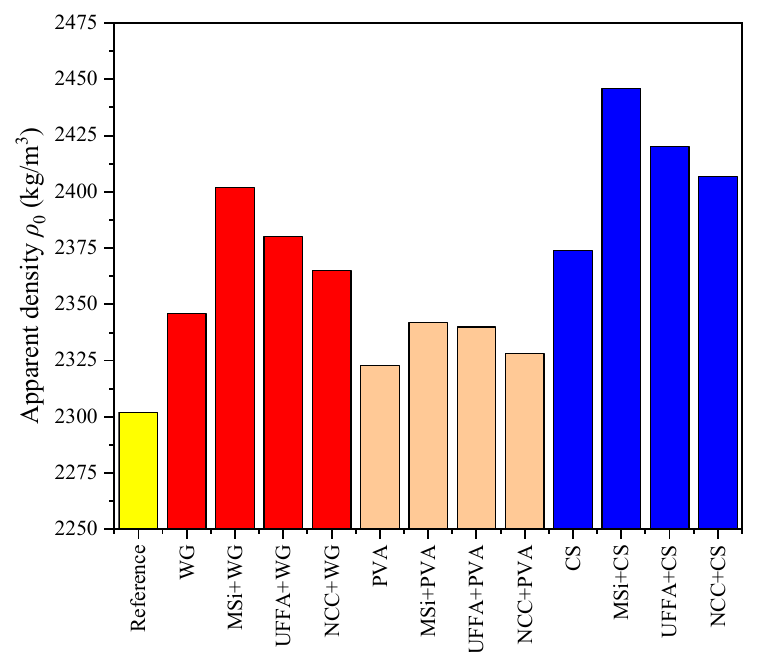
Figure 6. Apparent density ρ 0 for recycled aggregates with different strengthening methods. The results indicate that the trends of the variation of the crushing value Q c and the apparent density ρ 0 under different strengthening methods are correlated. It shows that a high apparent density ρ 0 is usually observed if the strengthened recycled aggregates have a high crushing value Q c . It is because both ρ 0 and Q c are related to the compactness degree of the recycled aggregates. In general, the higher the hydration degree of the reaction product between the aggregates and the strengthening materials, the denser the strengthened recycled aggregates and the higher the crushing resistance. To better capture their relationship, the apparent density ρ 0 was plotted against the crushing value Q c for all 13 cases, as shown in Figure 7. A curve-fitting equation was also obtained as follows with a correlation coefficient R 2 of